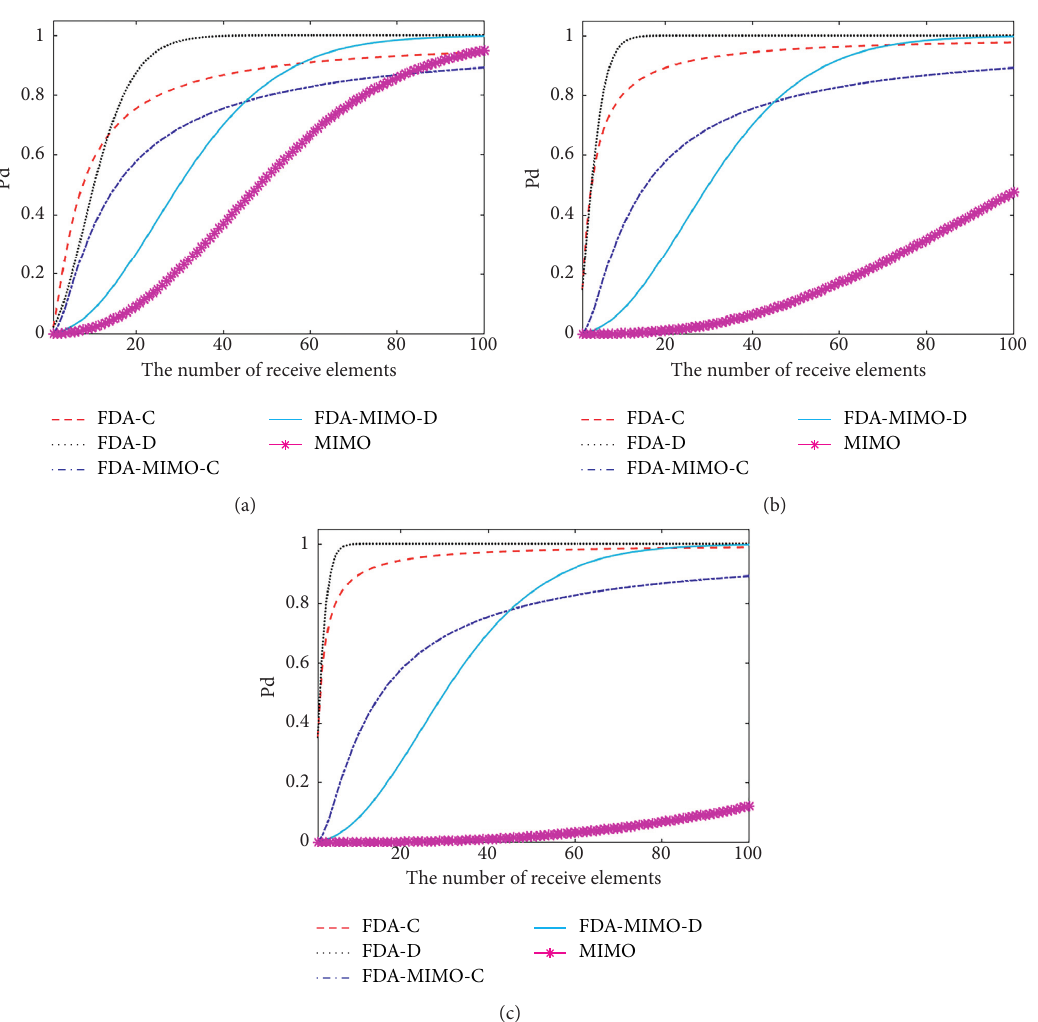
Figure 5: The influence of the array element number on detection probability at the SNR of 0 dB. (a) M � 2. (b) M � 5. (c) M �